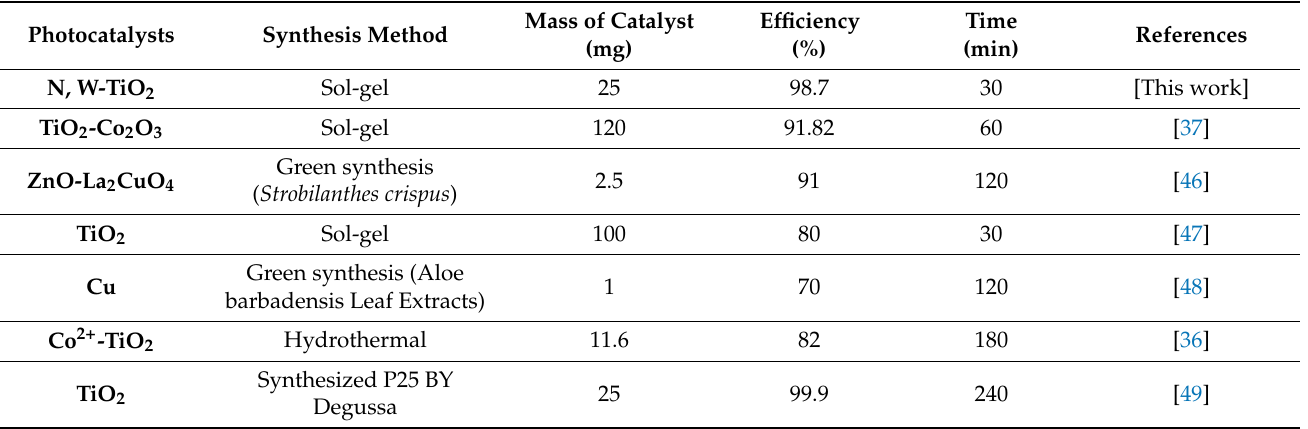
The activity of nanomaterials for photodegradation of malachite green dye in a previous